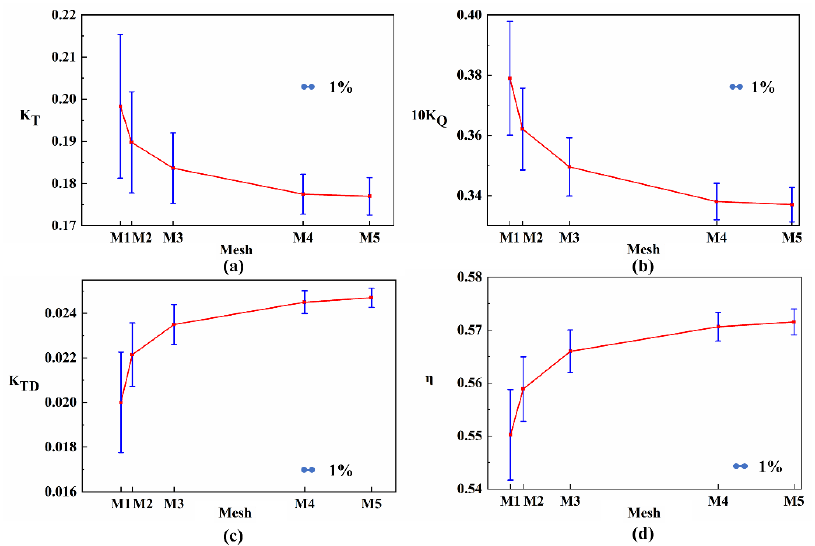
Figure 7. Open-water performance simulation results and error percentages with experimental values: ( a ) Change of K T with mesh number; ( b ) Change of 10K Q with mesh number; ( c ) Change of K TD with mesh number; ( d ) Change of η with mesh number.